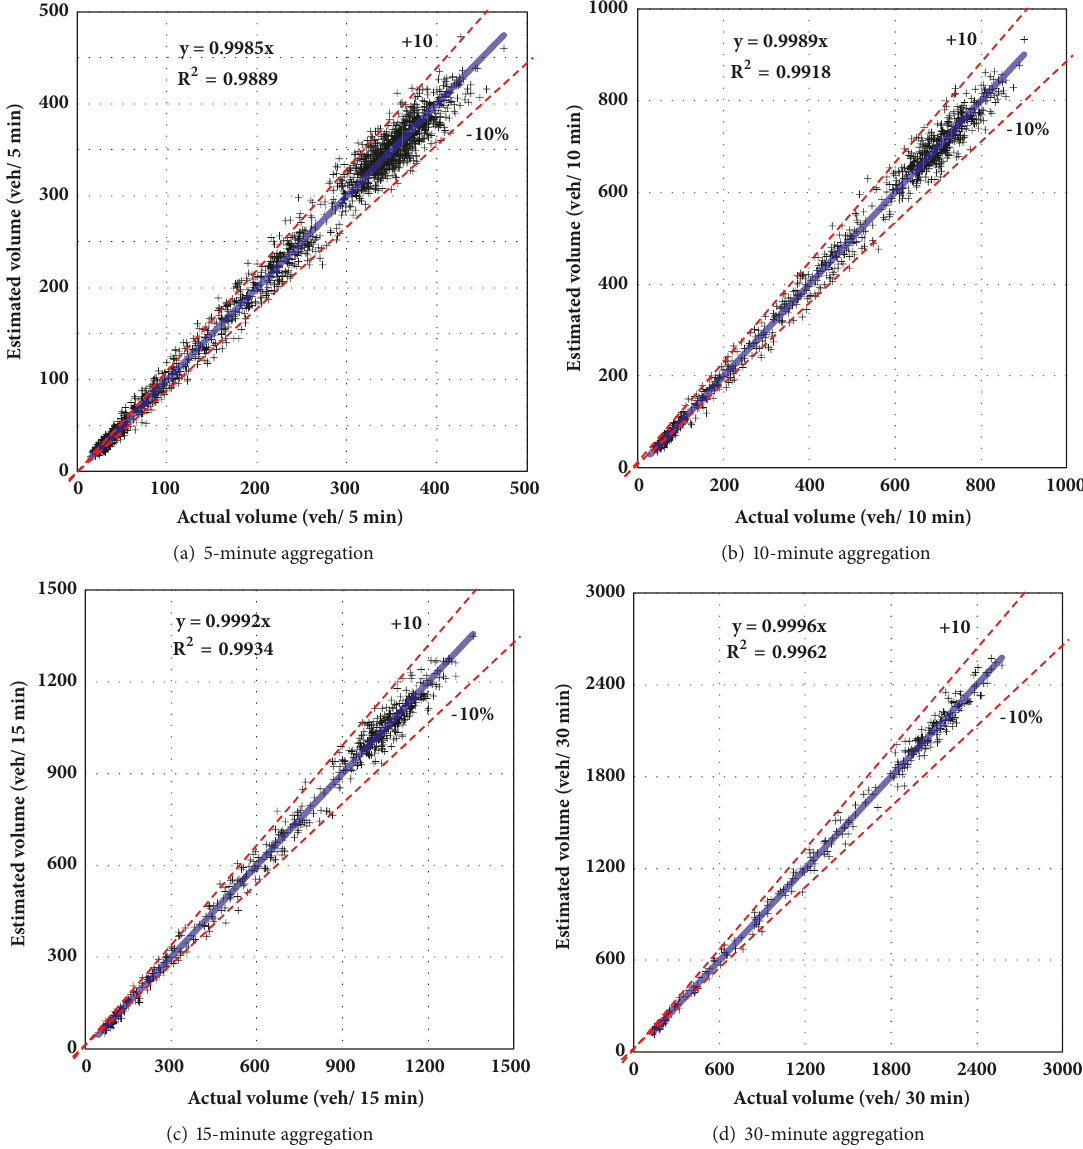
Figure 12: Predictability of the proposed model according to the aggregation